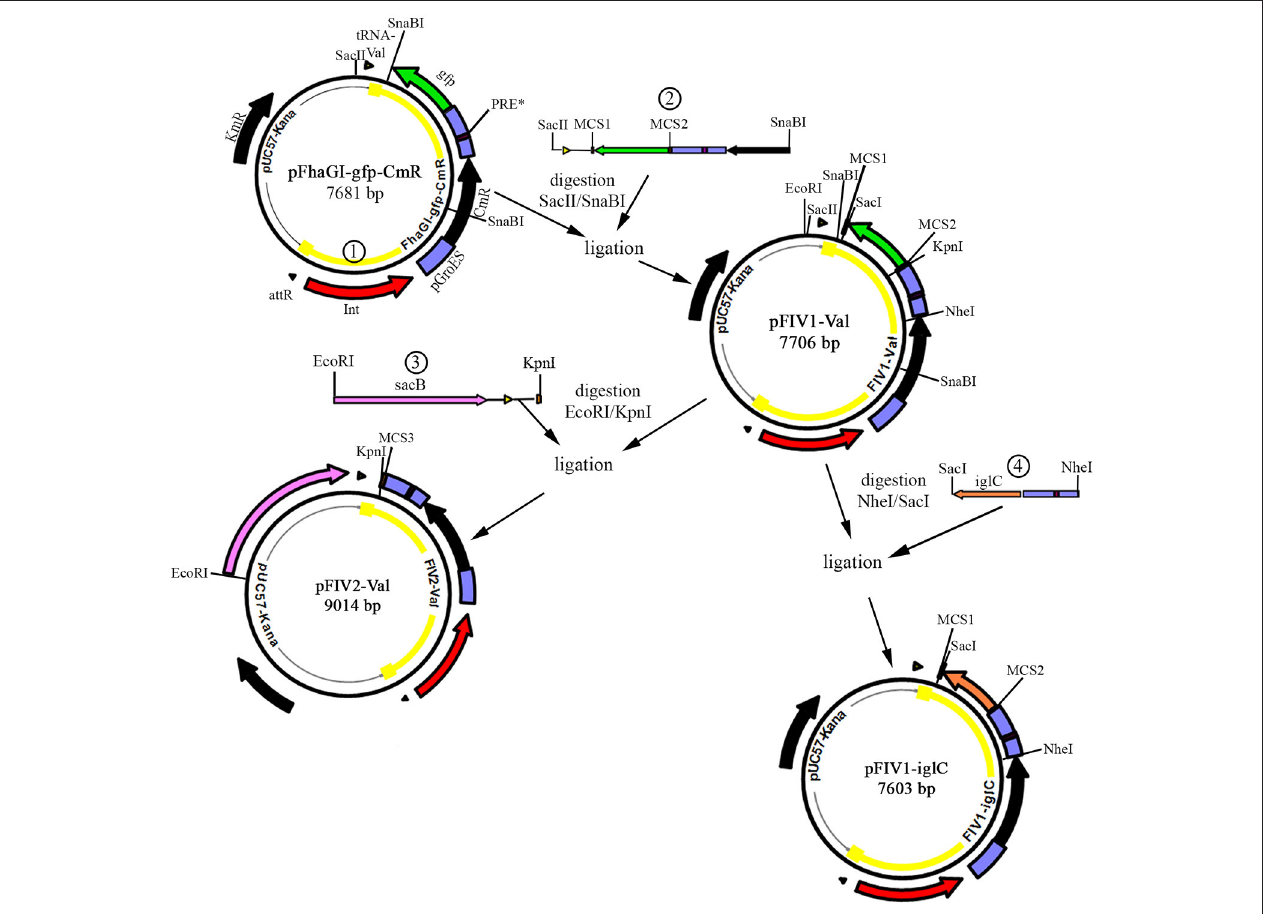
FIGURE 1 | Construction of FhaGI-1-derived vectors and cloning. Vector maps and restriction fragments for the construction of the different vector variants are shown. Antibiotic resistance cassettes for kanamycin (KmR) and chloramphenicol (CmR) are given in black; triangles represent tRNA-Val and attR and promotors are shown in blue; the integrase gene is shown in red; genes inserted into the MCS are shown in green ( gfp ) and orange ( iglC ); the SacB gene is shown in pink; and the FIV-Val part of the vectors that integrates into the genome of Francisella transformants is highlighted by a yellow line. Restriction sites used in this study are indicated. Numbers indicate constructs (1–4) used for cloning, see also Materials and Methods section. Detailed vector maps with primer binding sites are given in Figure S1